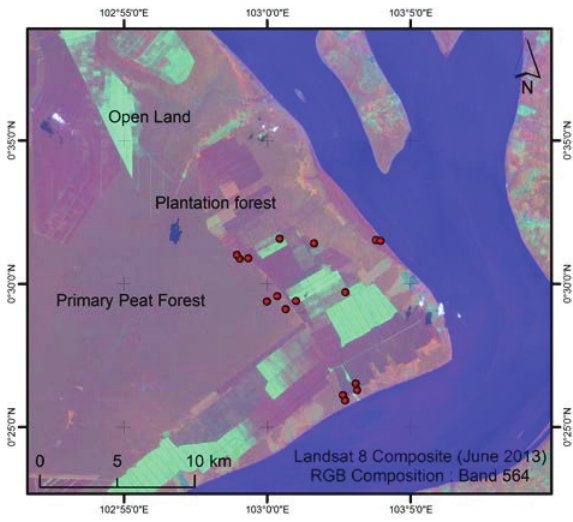
Figure 1 sampling distribution over the study area